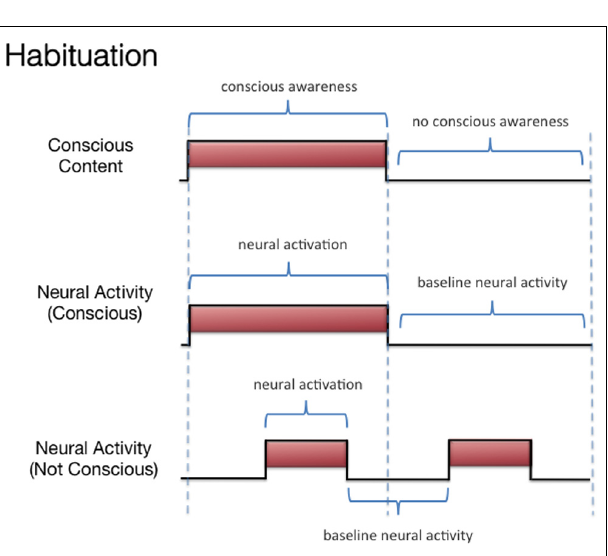
FIGURE 2 | Schematic representation of the relationship between the subjective events associated with conscious detection of olfactory stimuli and hypothetical neural activity.